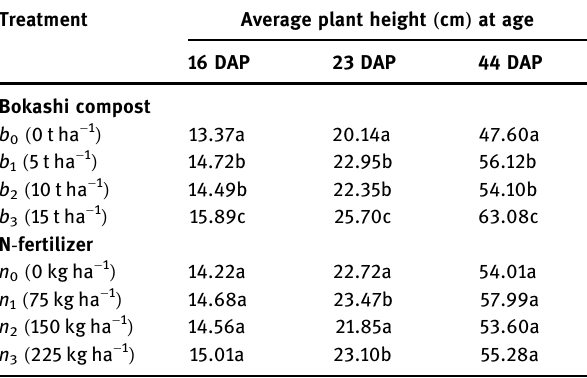
Table 2: Fermented compost and N - fertilizer on the plant height of the purple eggplant